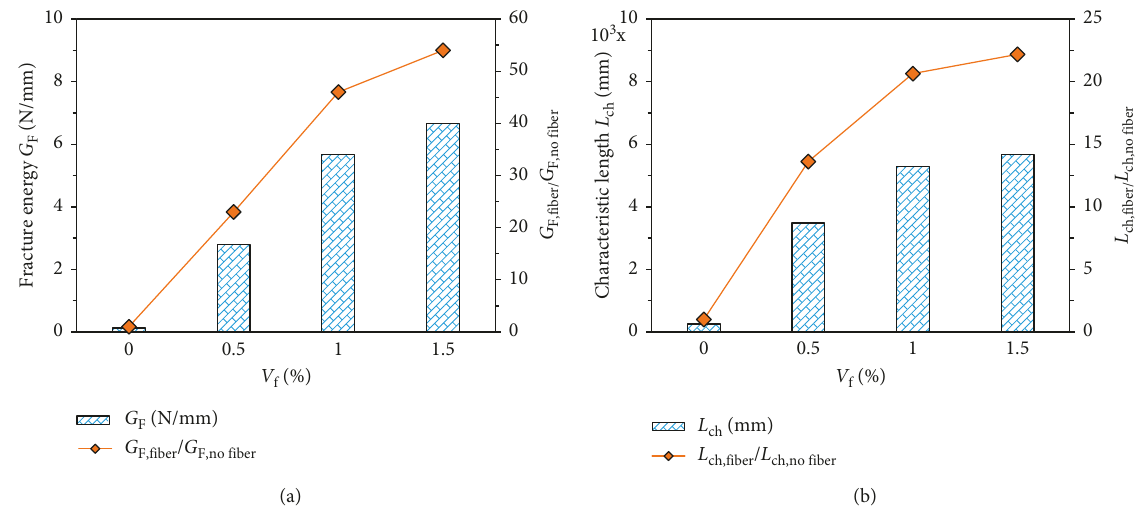
Figure 4: Experimental results of (a) fracture energy G